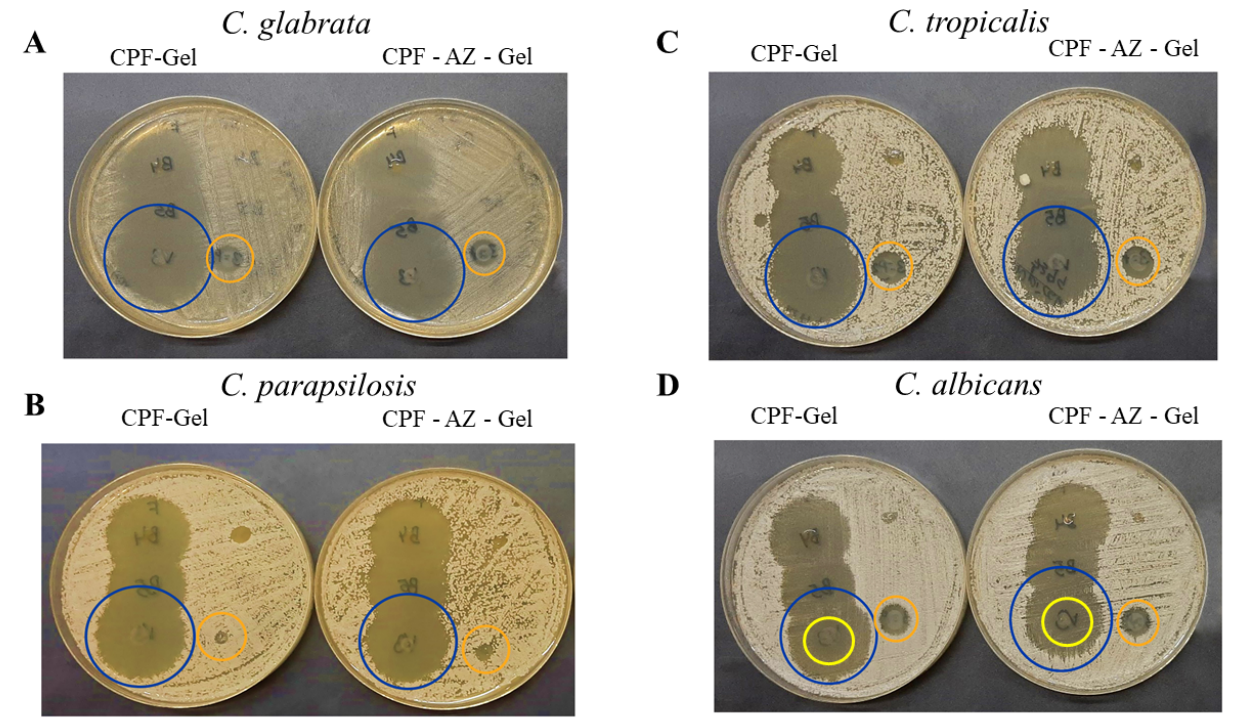
Table 6. Growth inhibition on Candida species.